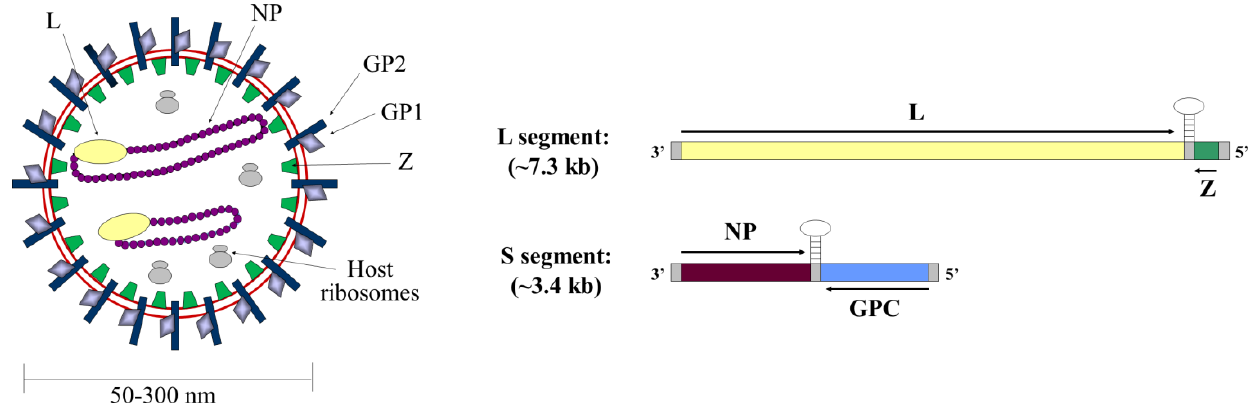
Figure 1. Arenavirus genome and virion structure. The general structure of an arenavirus particle (left panel) and the arenavirus genome (right panel) are shown. The mature viral glycoproteins GP1 and GP2 (shown in light and dark blue, respectively) are embedded in the viral envelope (shown in red). Beneath the viral envelope is the matrix protein Z (shown in green). The ribonucleoprotein complexes are composed of viral RNA (not visible) encapsidated by the nucleoprotein NP (shown in purple) and associated with the RNA-dependent RNA polymerase L (shown in yellow). In addition, arenavirus particles include host ribosomes (shown in grey) whose function remains unknown. The genes encoding for these viral proteins are arranged in ambisense orientation on the two genome segments. The small (S) segment encodes NP and the glycoprotein precursor (GPC), while the L segment encodes the polymerase L and the matrix protein